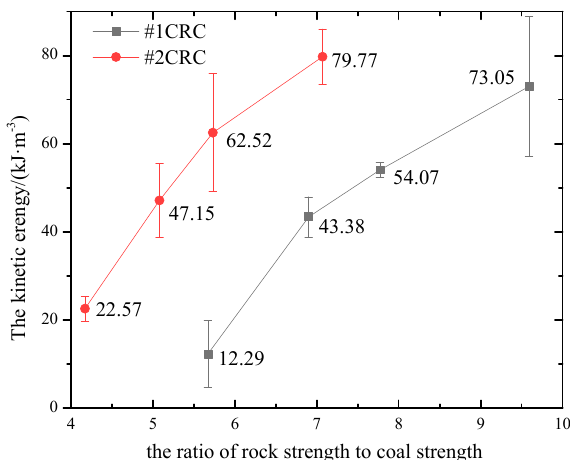
Figure 13. Relationship between the kinetic energy and rock / coal strength in CRC specimens.